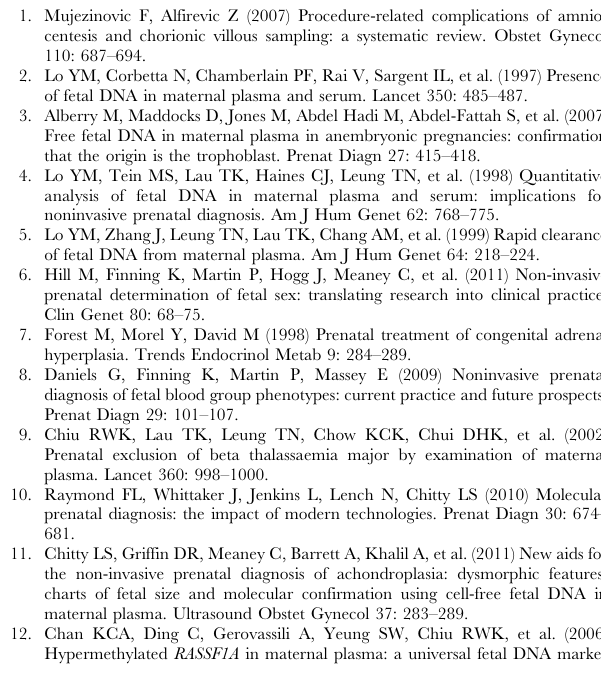
Figure S1 Examples of PCR amplification plots and melting profiles for the SRY and RASSF1A real time SYBR green PCR assays. Figure S2 (a) Amplification plots showing the difference in efficiency of three methylation sensitive RASSF1A restriction enzyme digest protocols using cell free DNA extracted from the plasma of a non-pregnant female. (b) Amplification plots showing an example of the difference in efficiency of two methylation sensitive RASSF1A restriction enzyme digest protocols using cell free DNA extracted from the same plasma sample from a pregnant female. Figure S3 Details of restriction enzyme